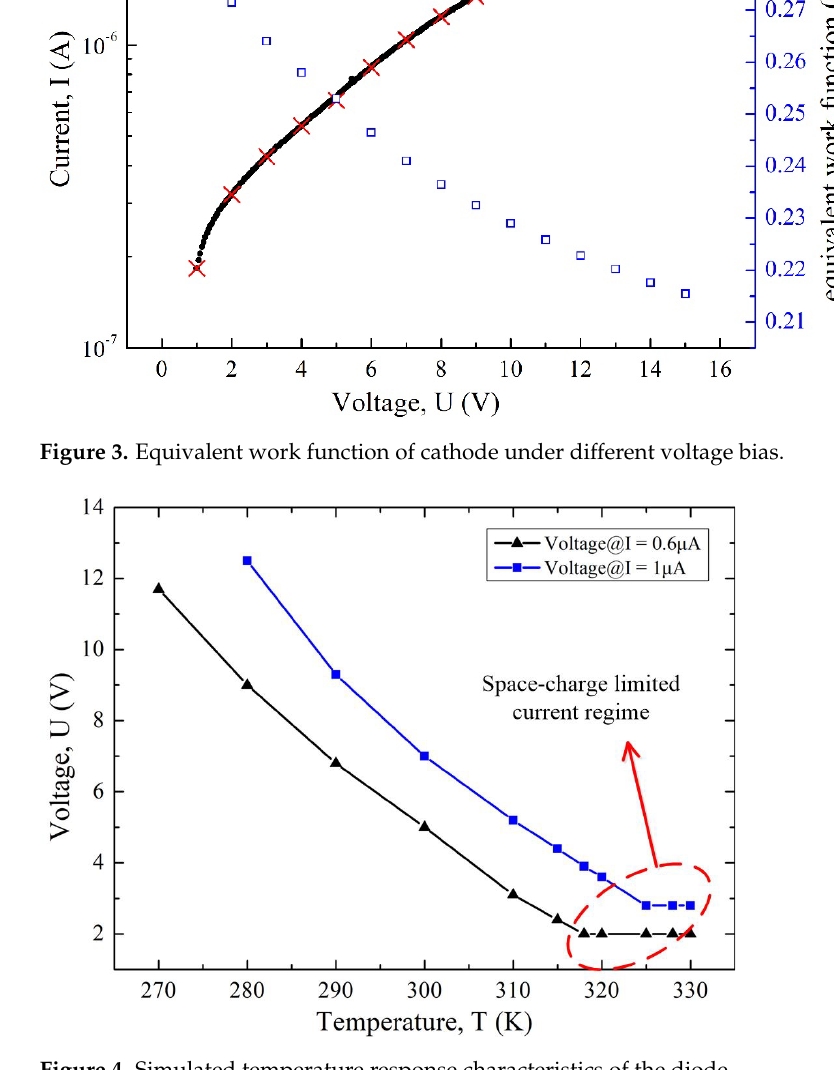
Figure 3. Equivalent work function of cathode under different voltage bias.